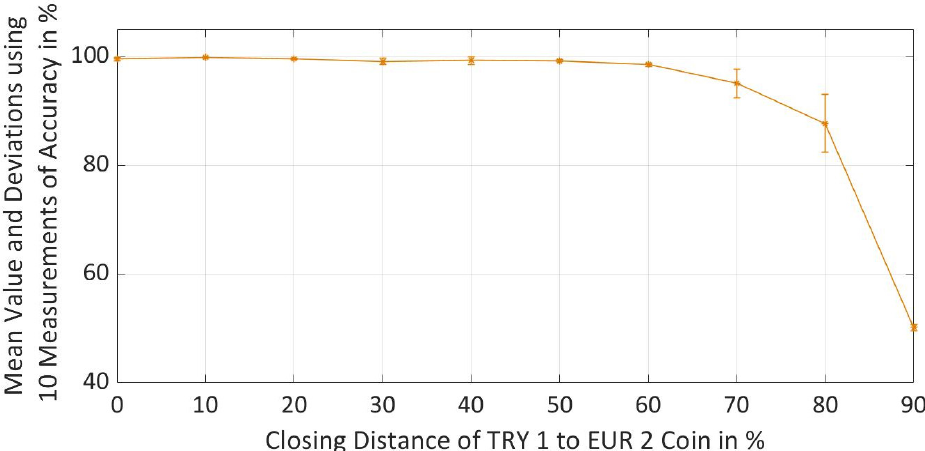
Figure 13. Reliability Evaluation of Pytorch with 32 Neurons in each Hidden Layer by Calculating the Mean Value, Minimum and Maximum Deviation using 10 Measurements for Accuracy Metric.